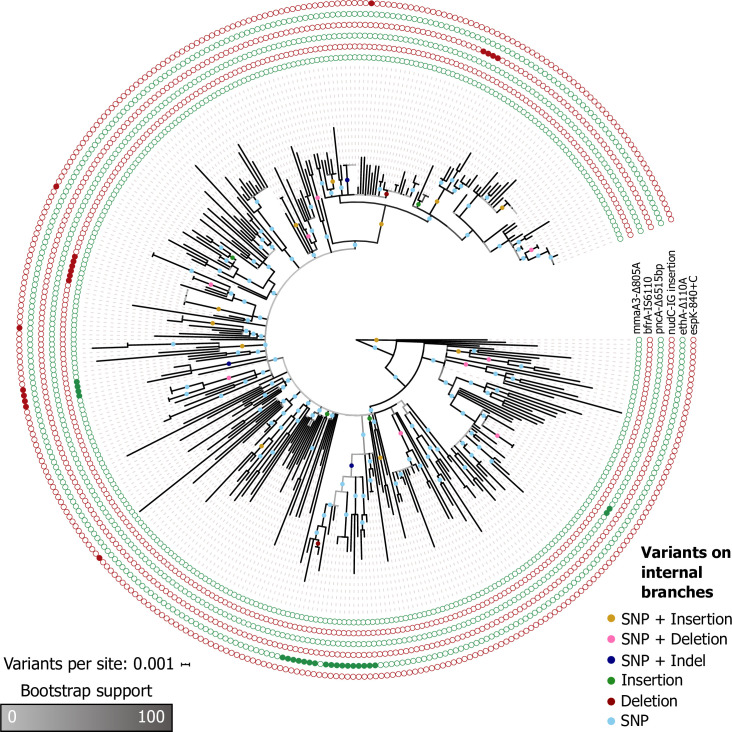
Phylogenetic tree of the CAO.486 (26.9%) of the variants are parsimony informative, and 56 variants (3.1%) are incompatible with the tree topology (Table 1). The root position is the temporal root estimated by dating the phylogeny with LSD. Circles on branches represent variants that are compatible with the branch, i.e., they likely have emerged on that branch. We found that six branches in the tree have only short indels (four branches with insertions, two branches with deletions). The outer circles show example variants that are highlighted in the text. The tree with the tip labels is available in the supporting information (S7 Fig).